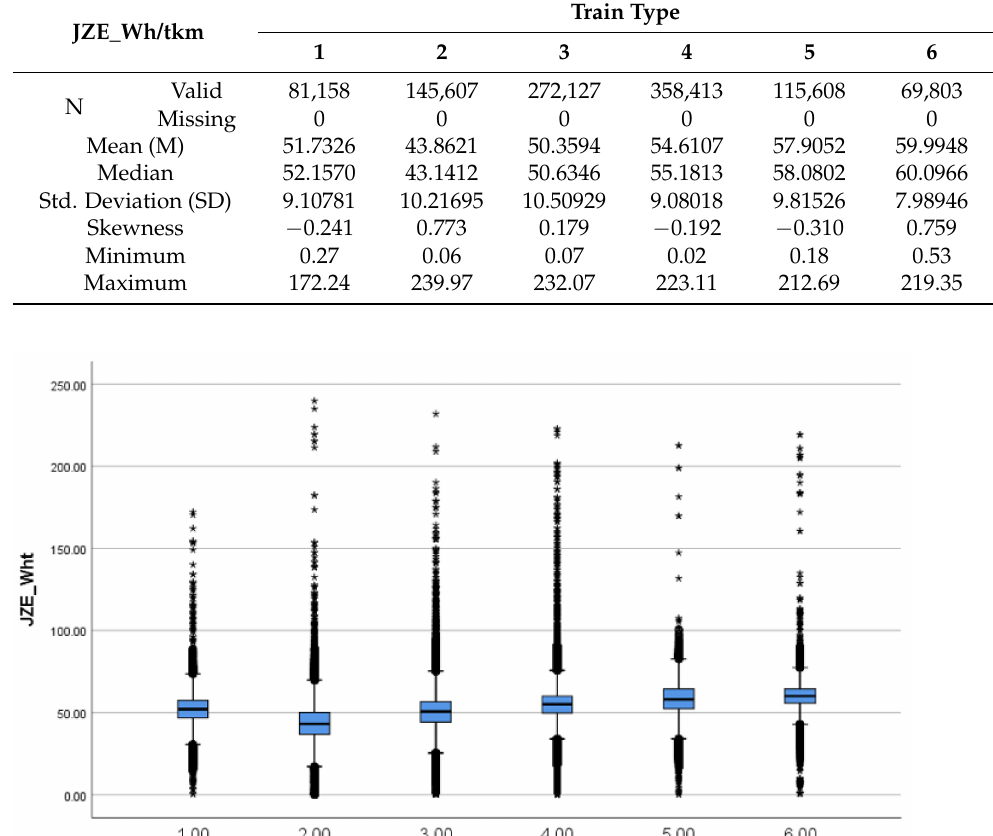
Table 4. Energy consumption descriptive statistics for each of the train types.